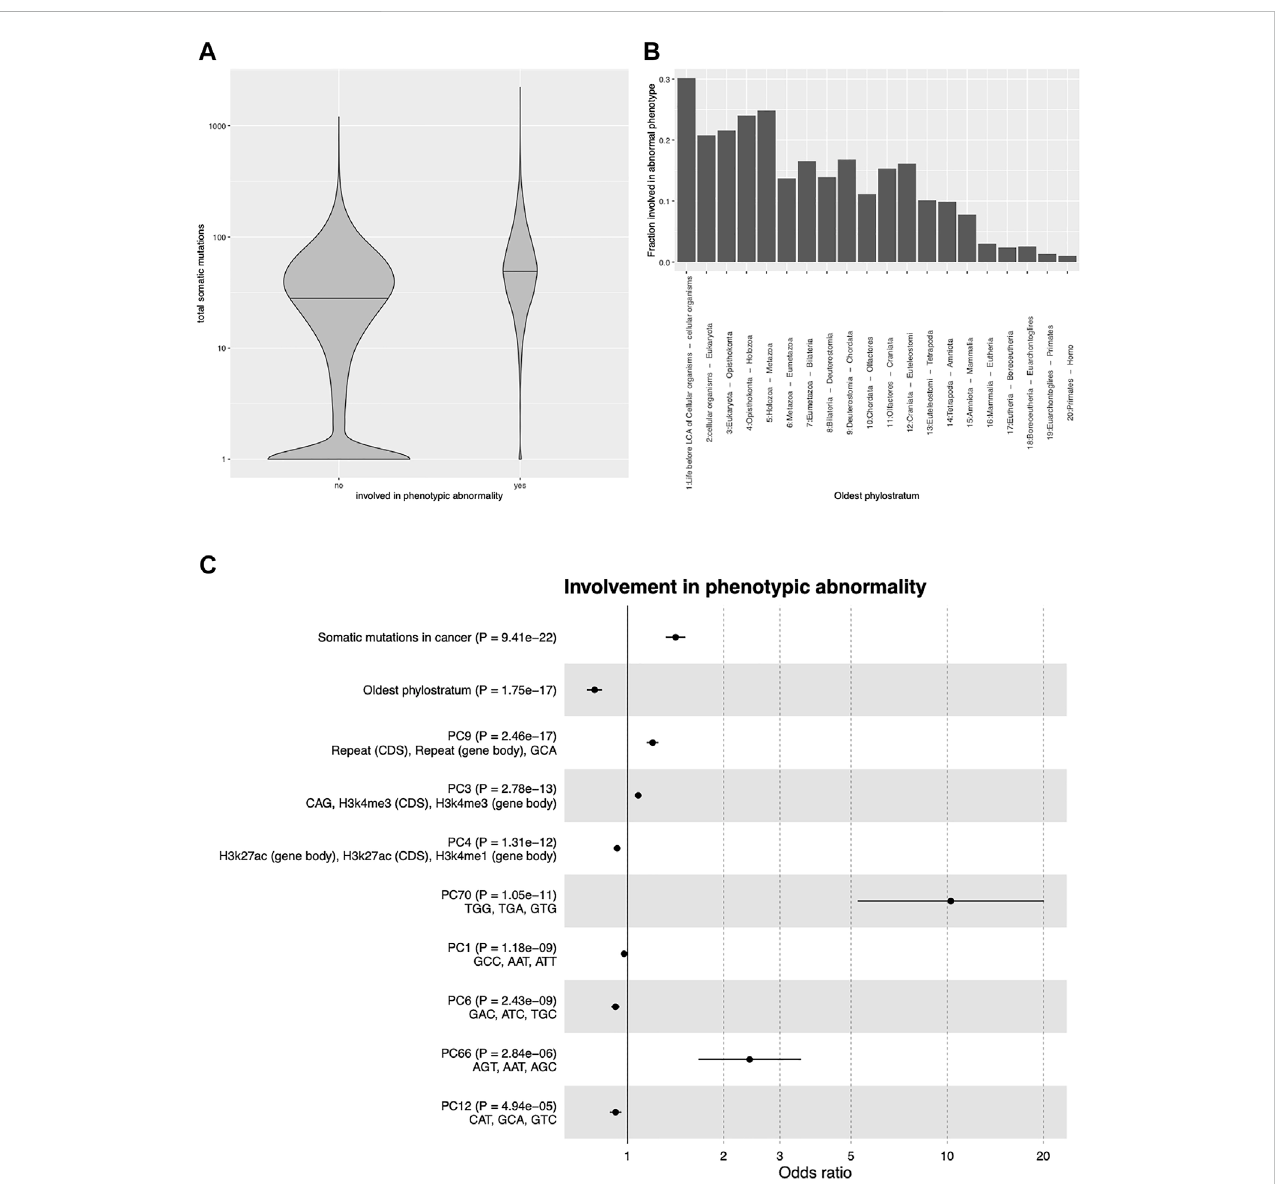
FIGURE 2 Predictors of involvement in phenotypic abnormality (A) : Number of cancer samples with somatic mutations in genes involved or not involved in phenotypicabnormalitiesaccordingtotheHumanPhenotypeOntology. (B) :Fractionofgenesinvolvedinphenotypicabnormalitiesasafunctionofgeneage. The x -axis shows thebranching ofthe tree oflife atwhich the geneappeared according to thereconstruction ofNeme and Tautz (2013). (C) : Odds ratios and p -values of each predictor of involvement in phenotypicabnormality ina multivariable logistic regressionwith cancer somaticmutations, gene age, and theprincipalcomponentsof80genomic/epigenomicfeatures.Thetop10predictorsby p -valueareshown.ForeachPC,thethreetopfeaturesbyloadingare shown. CDS, coding sequence; PC, principal component; trinucleotides refer to their respective frequency in the coding